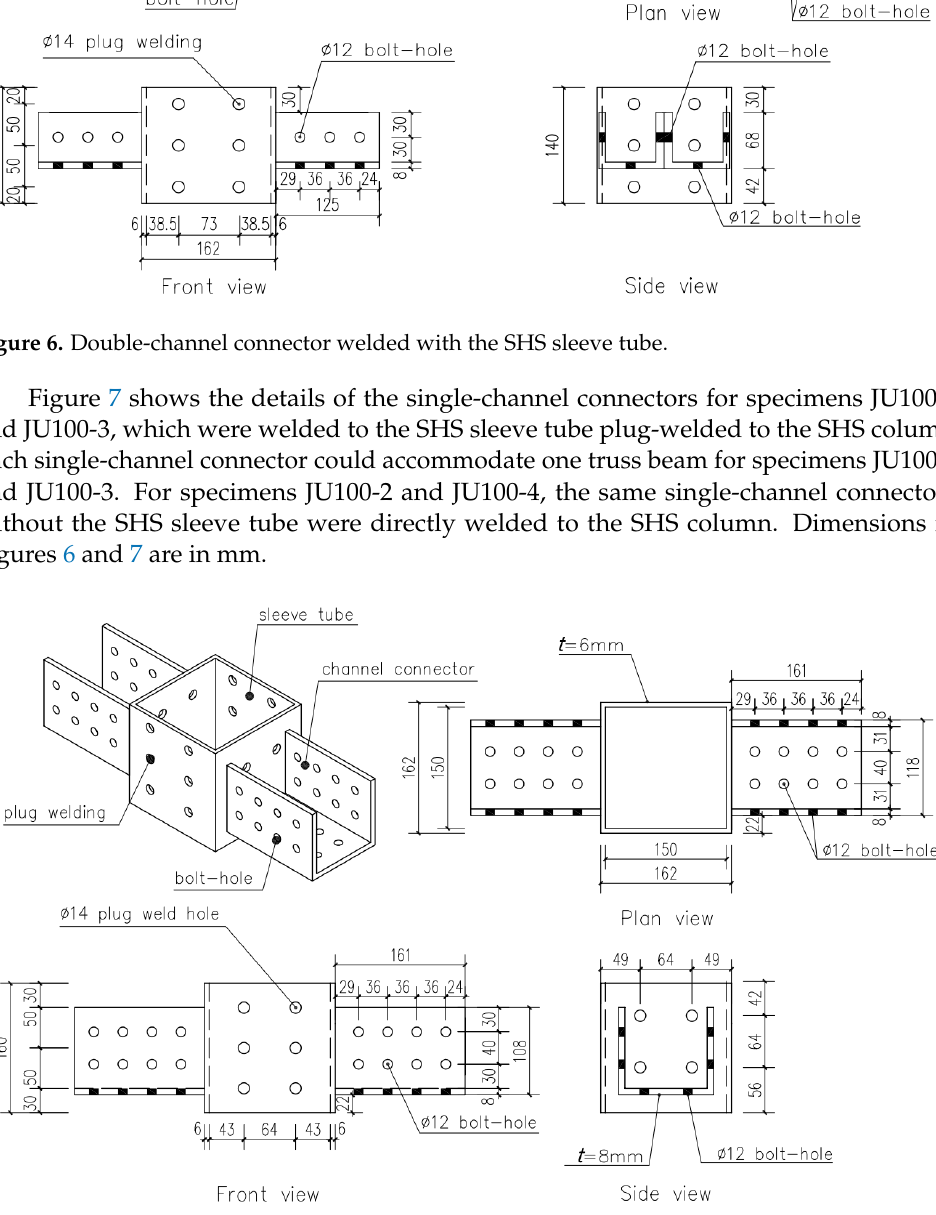
Figure 7. Single-channel connector welded with the SHS sleeve tube.